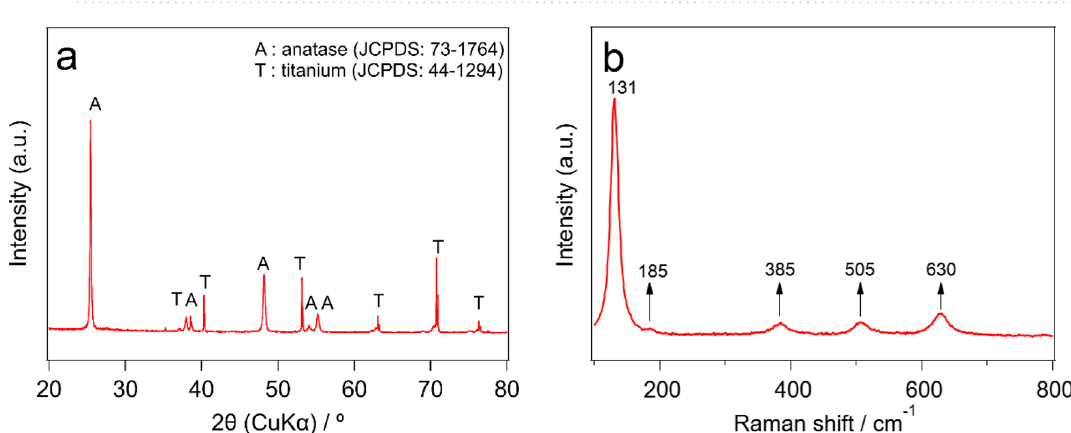
Figure 2. ( a ) XRD pattern and ( b ) Raman spectrum of TNTAs prepared by 1 h second